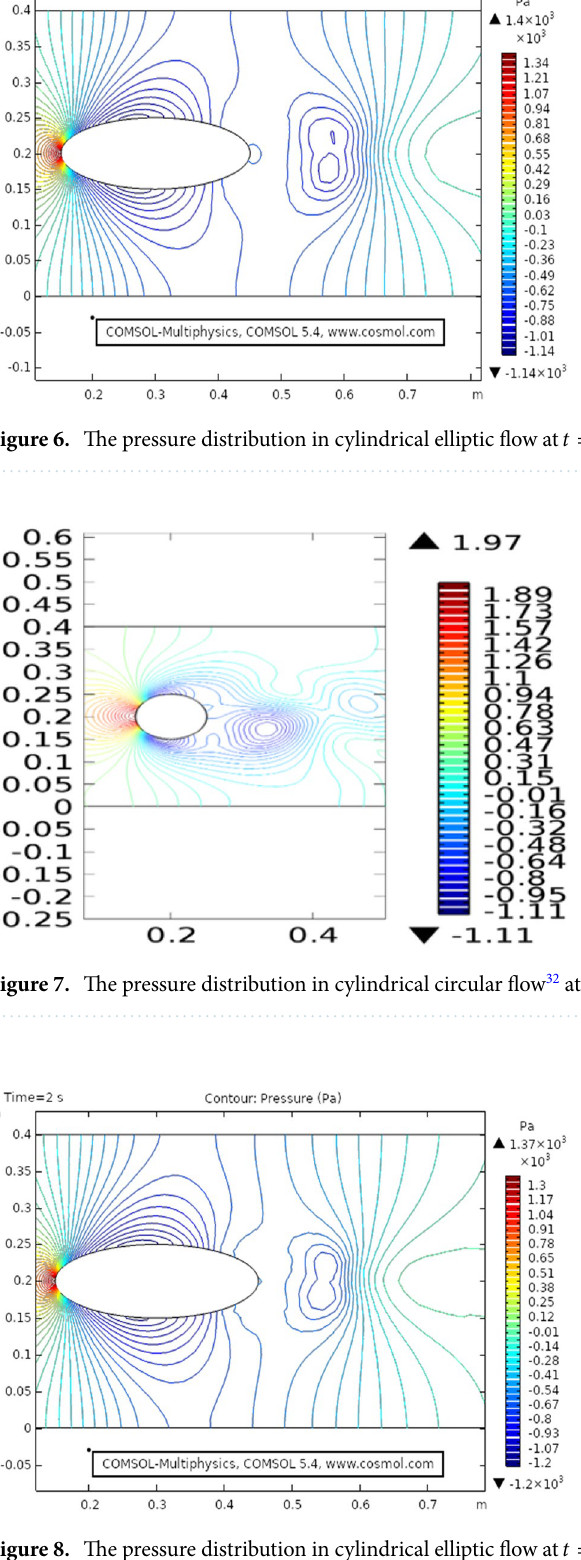
Figure 8. The pressure distribution in cylindrical elliptic flow at t = 2 s